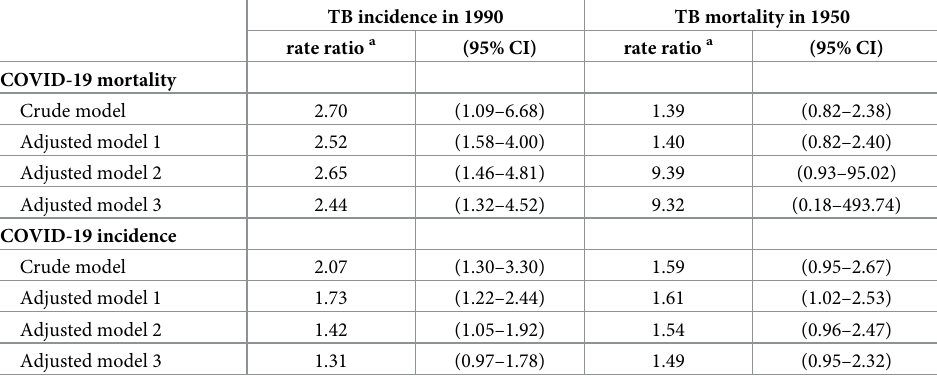
(per 1 million people) on 5 April